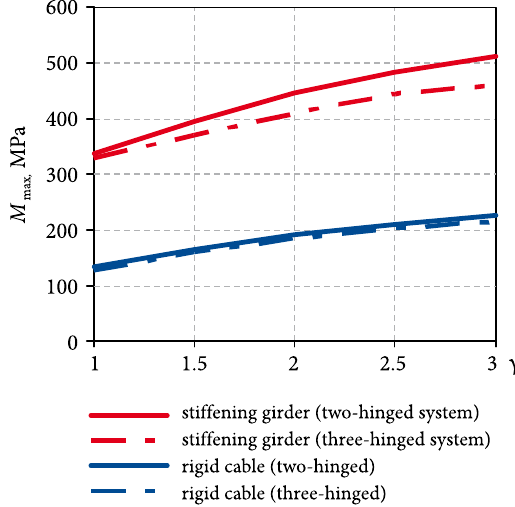
Fig. 10. Comparison between the max bending moments of the stiffening girder and rigid cable in two and three-hinged system vs ratio γ